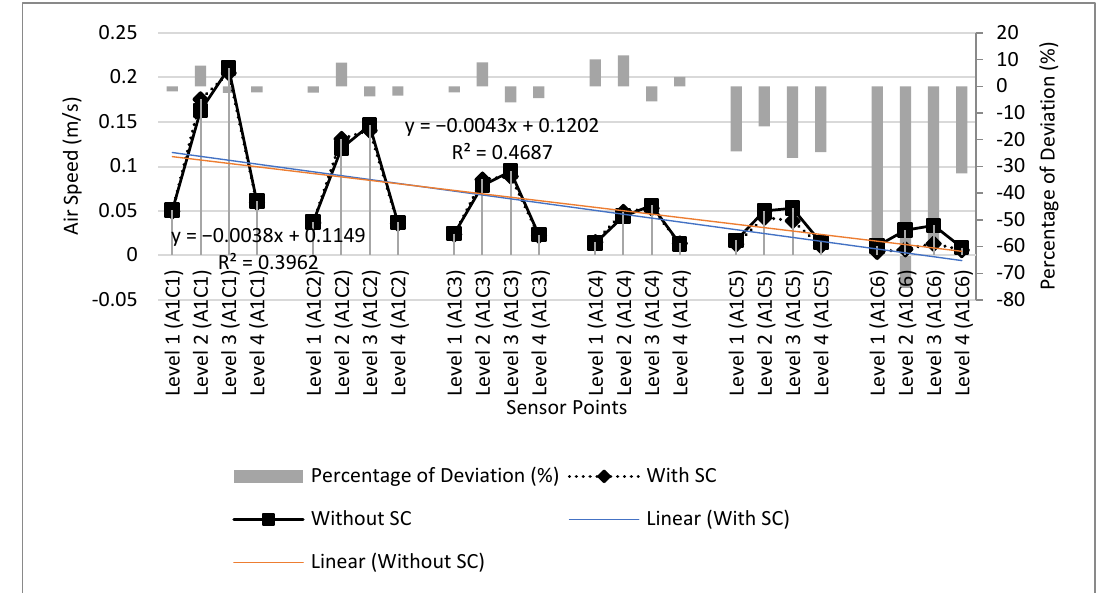
Figure 11. Comparison of indoor air speed between a room with an SC and a room without an SC, without the assistance of a ceiling fan.